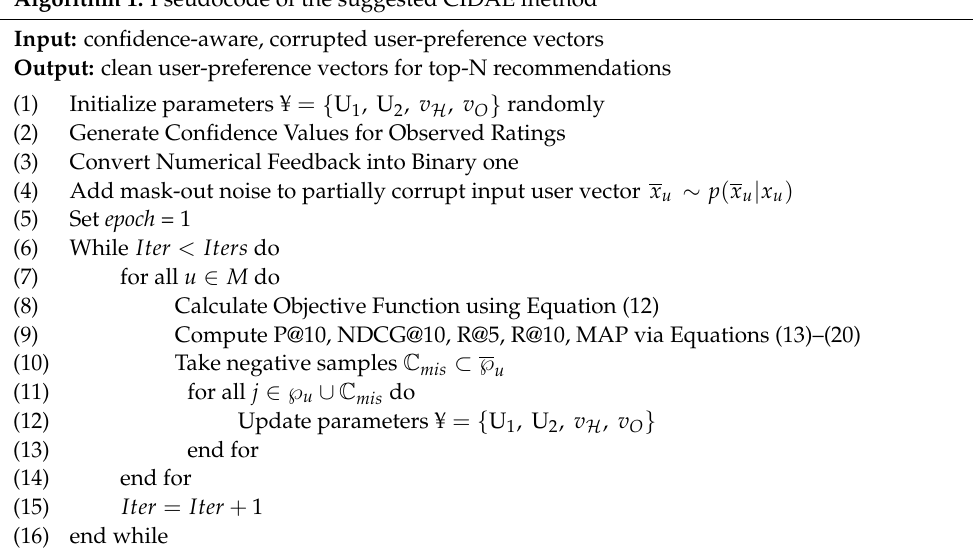
Algorithm 1. Pseudocode of the suggested CIDAE method